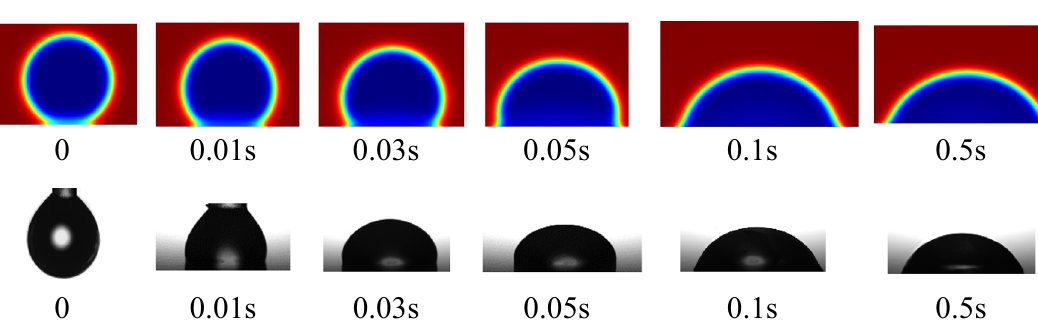
Figure 10. Comparison of simulated and real droplet spreading